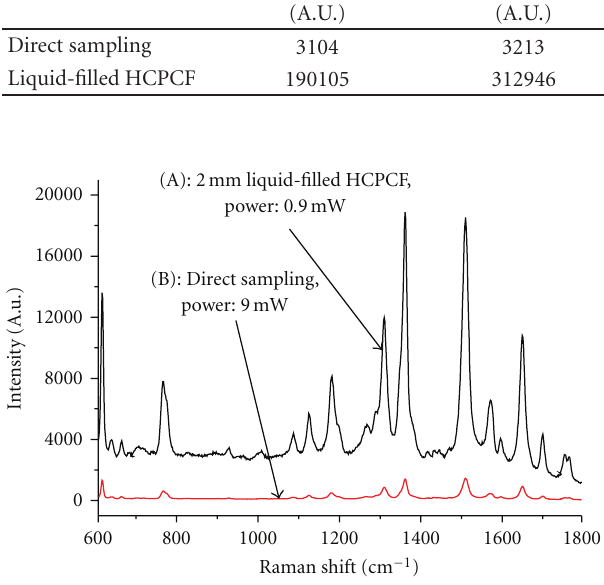
Figure 6: Schematic of the inner wall-coated LCPCF sensor.